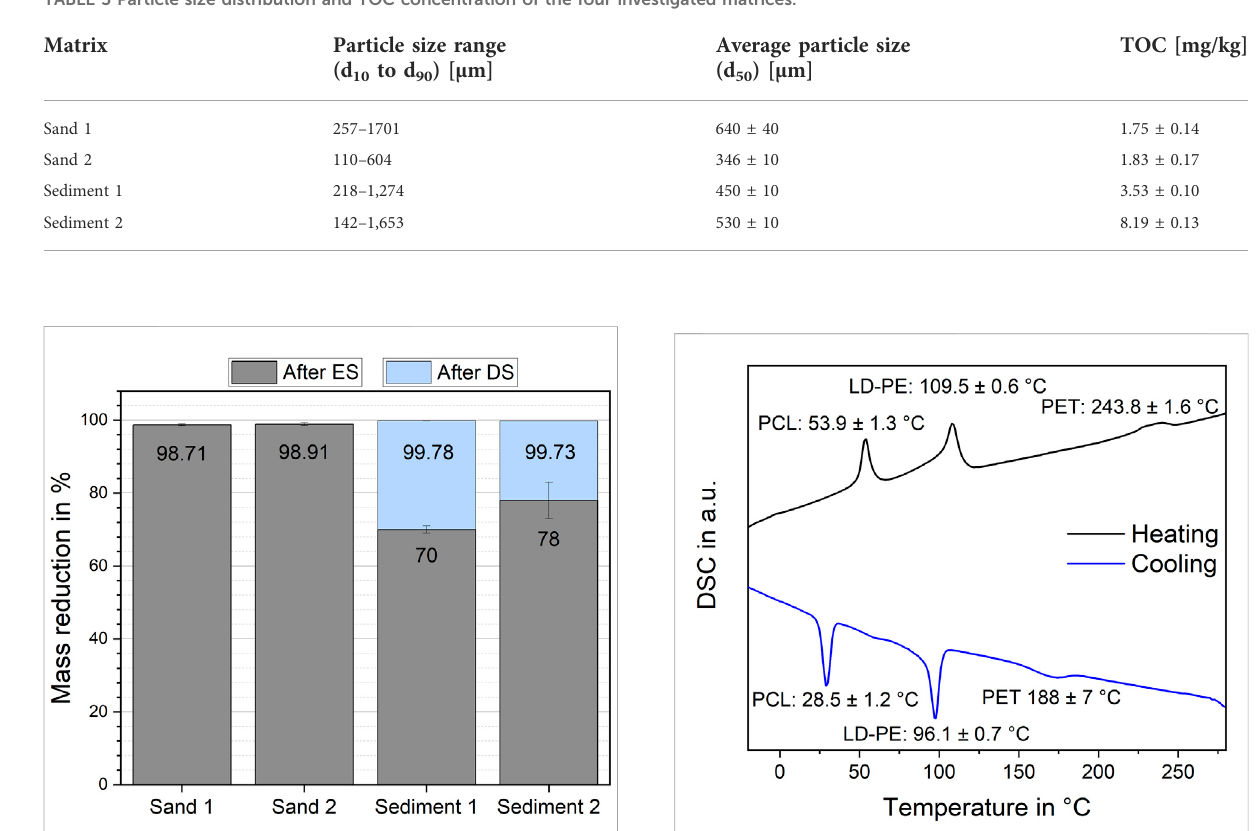
FIGURE 1 Mass reduction of the investigated particulate matrices by electrostatic separation (ES) and subsequent density separation (DS) of sediment 1 and sediment 2.